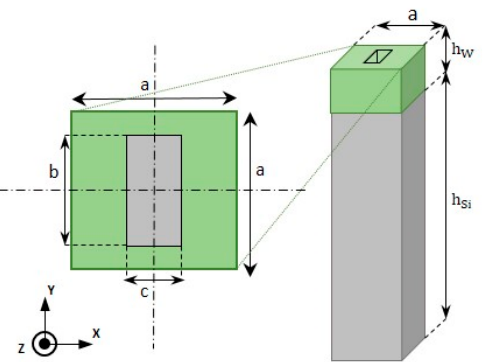
Figure 1. Scheme of the square cuboid unit cell (lattice constant a ) composed of Si substrate (grey; thickness h Si ) and tungsten film (green; thickness h W ). Position and dimensions (length c and width d ) of the parallepipedic hole dug in the tungsten film are indicated.